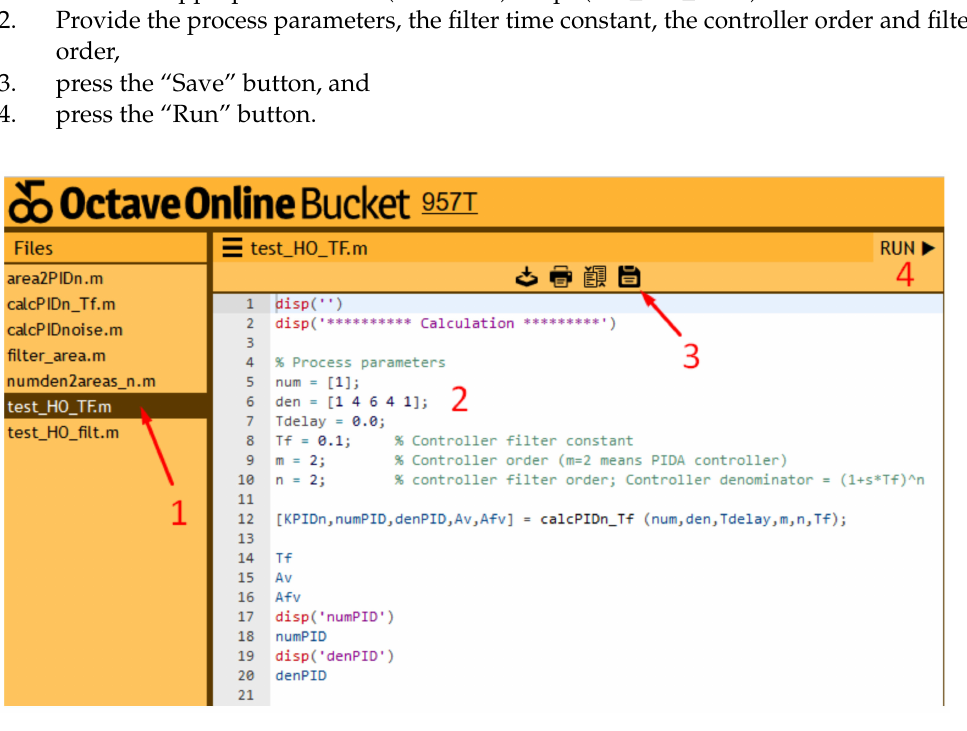
Figure 2. The layout of the OctaveOnline Bucket website (function